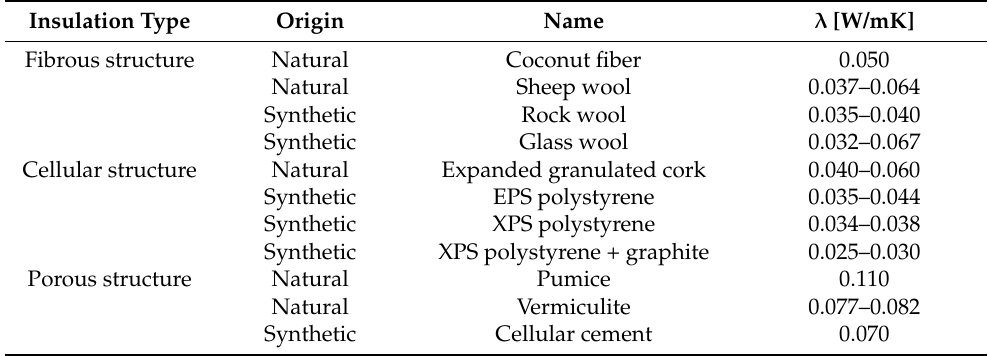
Table 1. Types and average thermal performance of some traditional thermal insulation